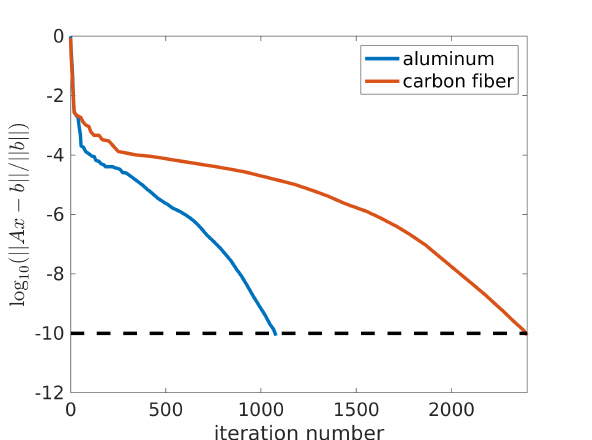
Figure 4. Convergence of the GMRES solver when the coils are perfectly aligned in the case of a car body made of aluminum (blue) or carbon fiber